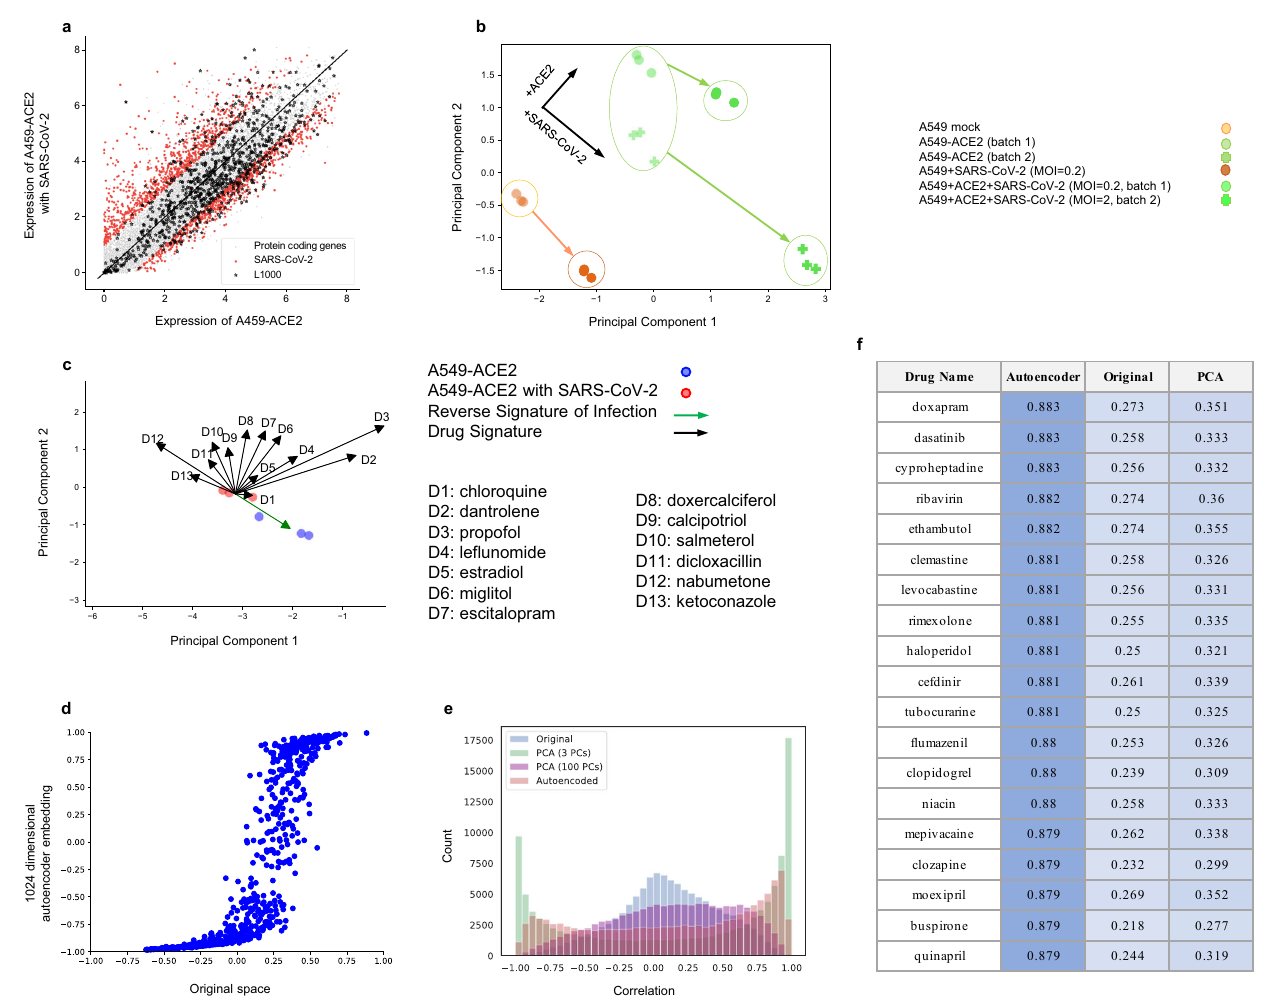
Fig. 3 Mining FDA-approved drugs by correlating disease and drug signatures using an overparameterized autoencoder embedding. a Gene expression (log 2 RPKM + 1) of A549-ACE2 cells infected with SARS-CoV-2 versus normal A549-ACE2 cells with genes collected as part of the CMap study using the L1000 reduced representation expression pro fi ling method highlighted as stars, showing that L1000 genes signi fi cantly overlap with SARS-CoV-2 associated genes, shown in red, ( p value = 7.94 × 10 − 16 , one-sided Fisher ’ s exact test). b Signature of SARS-CoV-2 infection on A549 and A549-ACE2 cells visualized using the fi rst two principal components based on RNA-seq data from ref. 23 . The signature of SARS-CoV-2 infection is aligned across normal A549 and A549-ACE2 cells as well as across different levels of infection. Green and orange points indicate data from A549-ACE2 and A549 cells, respectively. Circles and crosses indicate data from two different batches, the multiplicity of infection (MOI) of 0.2 versus 2, respectively. c Comparison of the signatures of a selection of 13 representative FDA-approved drugs (black arrows) as compared to the reverse signature of SARS-CoV-2 infection based on A549-ACE2 cells (green arrow) visualized using the fi rst two principal components. Drugs whose signatures maximally align with the direction from SARS-CoV-2-infected cells (red) to normal cells (blue) are considered candidates for treatment. As expected, drugs have varying signatures of varying magnitudes. d Correlation between drug signatures in A549 and MCF7 cells when using the original L1000 expression space versus the embedding obtained from an overparameterized autoencoder. The overparameterized autoencoder aligns the drug signatures in A549 and MCF7 cells by shifting the correlations towards − 1 or 1 while maintaining the sign of the correlation in the original space. e Histogram of correlations between cell types for a given drug using original L1000 gene expression vectors (blue), overparameterized autoencoder embedding (pink), top 100 principal components (purple), and top 3 principal components (green). The overparameterized autoencoder achieves about the same alignment of drug signatures as using the top three principal components, while at the same time faithfully reconstructing the data (10 − 7 training error). f A list of drugs whose signatures maximally align with the direction from SARS-CoV-2 infection to normal in A549-ACE2 cells (MOI 2) with respect to correlations using the overparameterized autoencoder embedding, the original L1000 gene expression space, and the top 100 principal